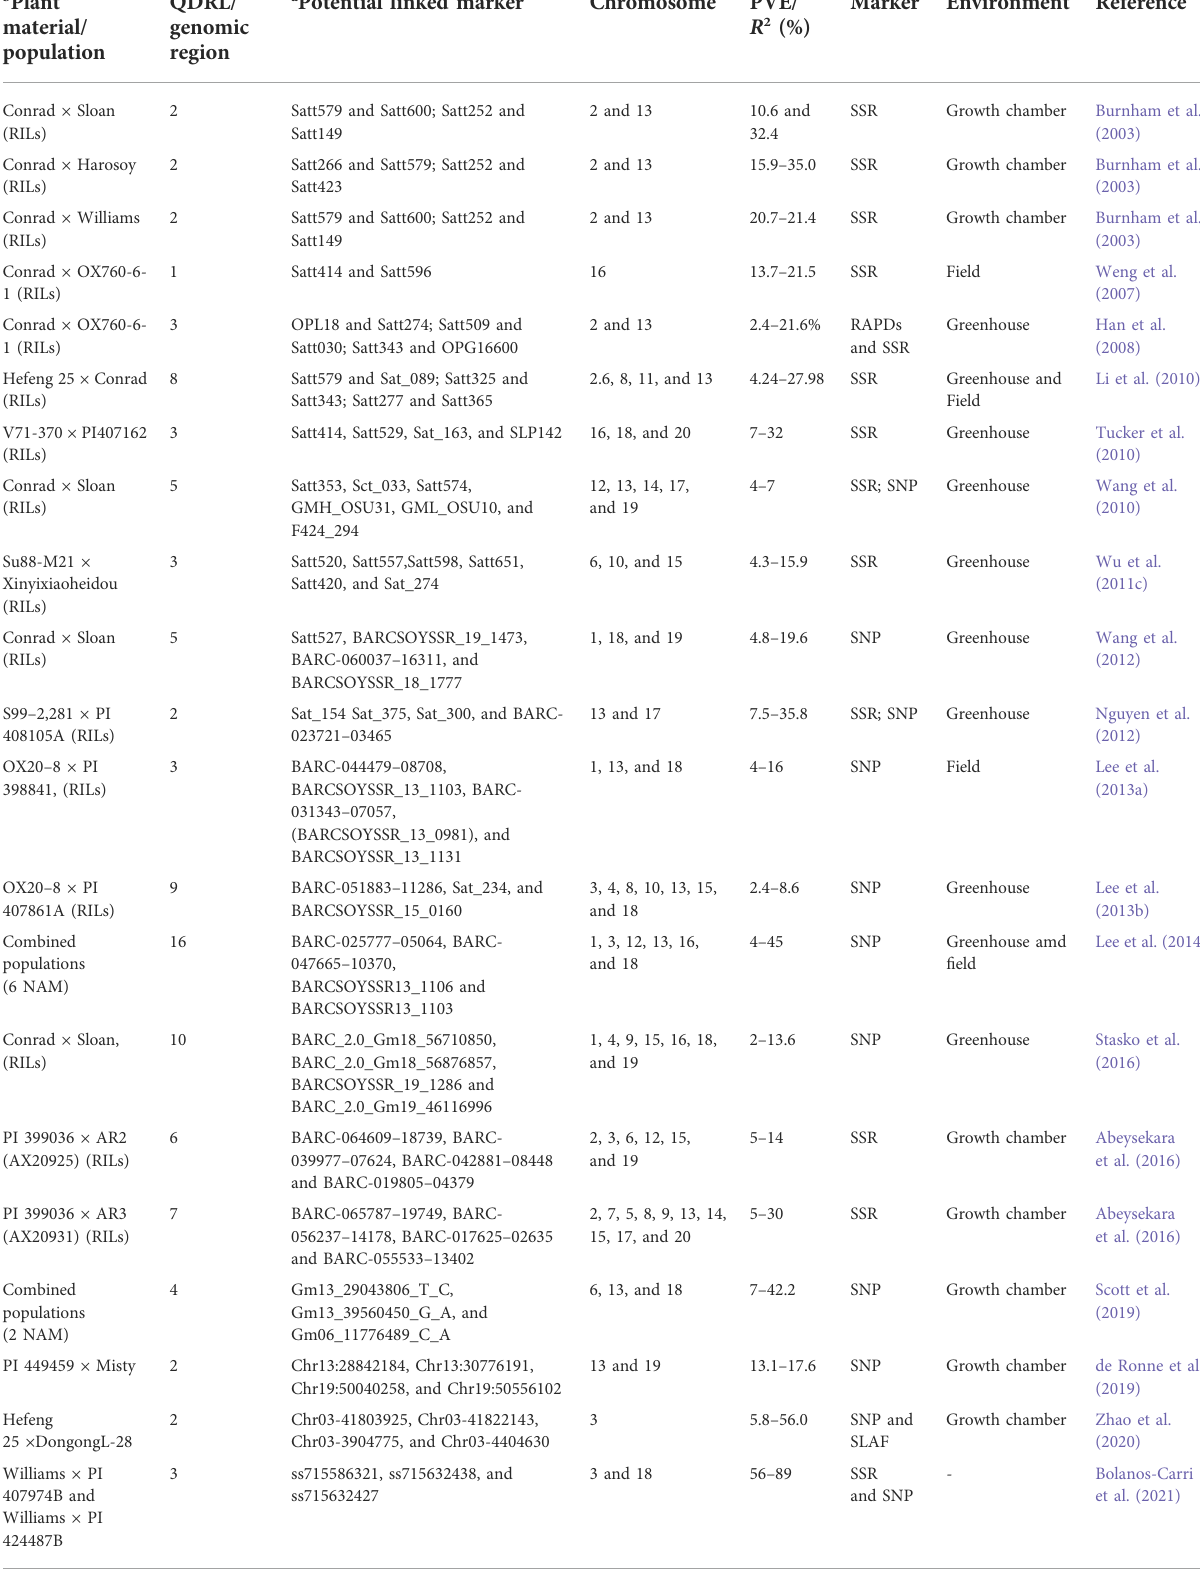
TABLE 2 Details of QDRL for P. sojae resistance identi fi ed through the bi-parental mapping approach in soybean. b